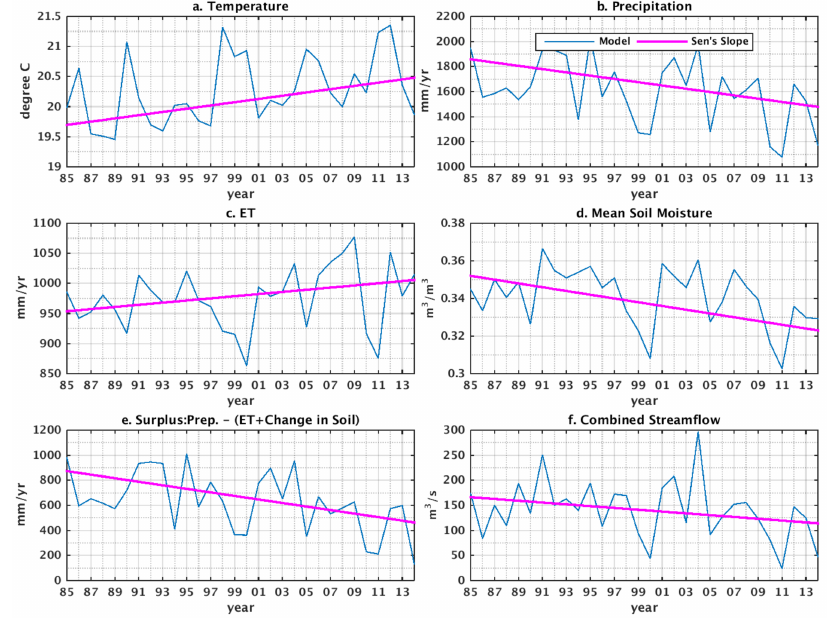
Figure 9. Annual mean time series of NLDAS-2 ( a ) temperature and ( b ) precipitation, and model simulated ( c ) evapotranspiration, ( d ) soil moisture, ( e ) water surplus, ( f ) combined streamflow averaged through the three basins for year 1985–2014. Also shown in each figure is the Sen’s Slope